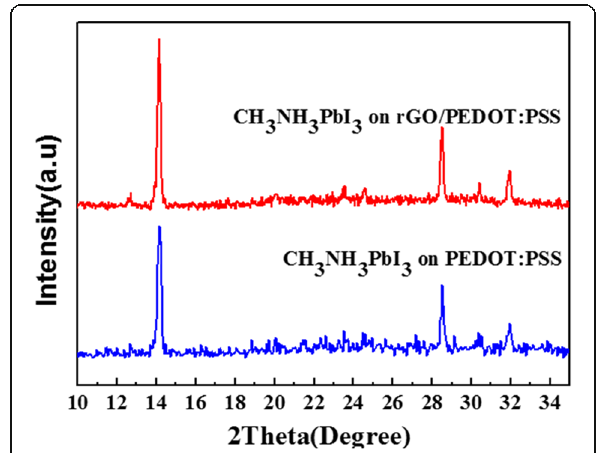
Fig. 3 XRD patterns of the perovskite films on rGO/PEDOT:PSS